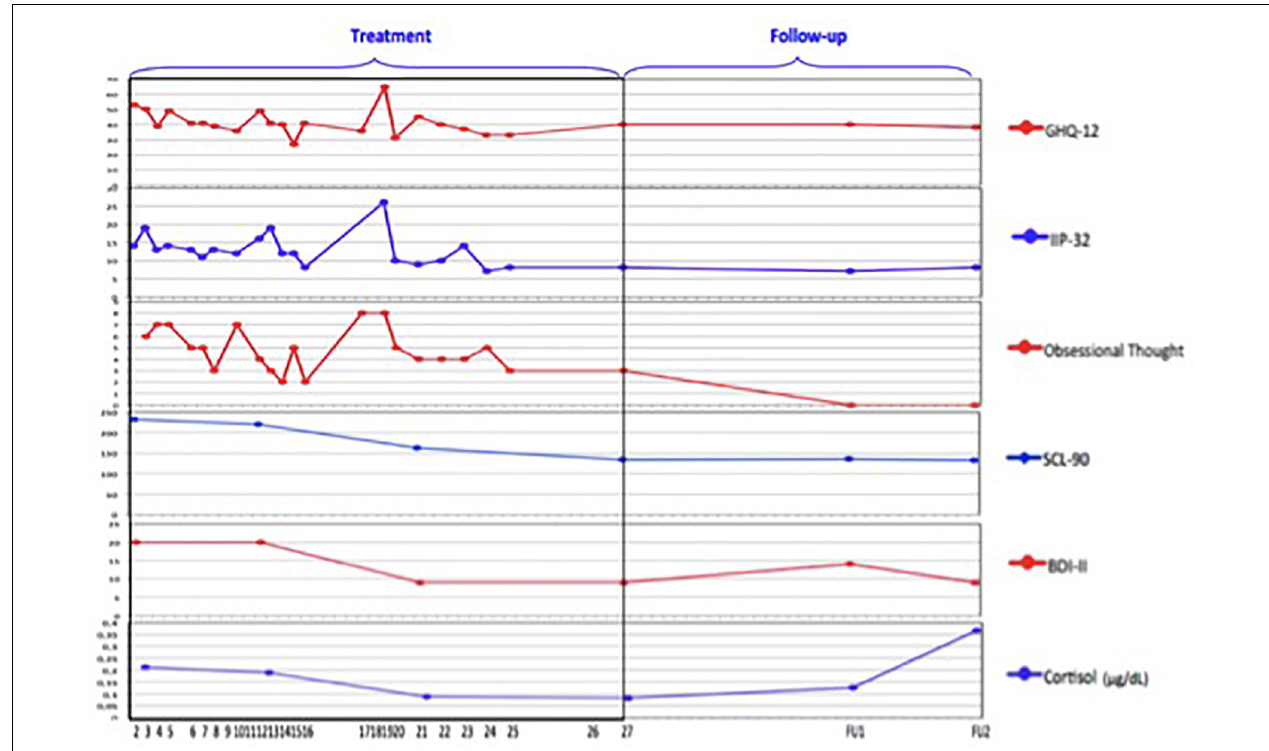
FIGURE 3 | Individual outcome measure battery throughout treatment for patient James (retrieved from Cornelis et al., 2017; reprinted with